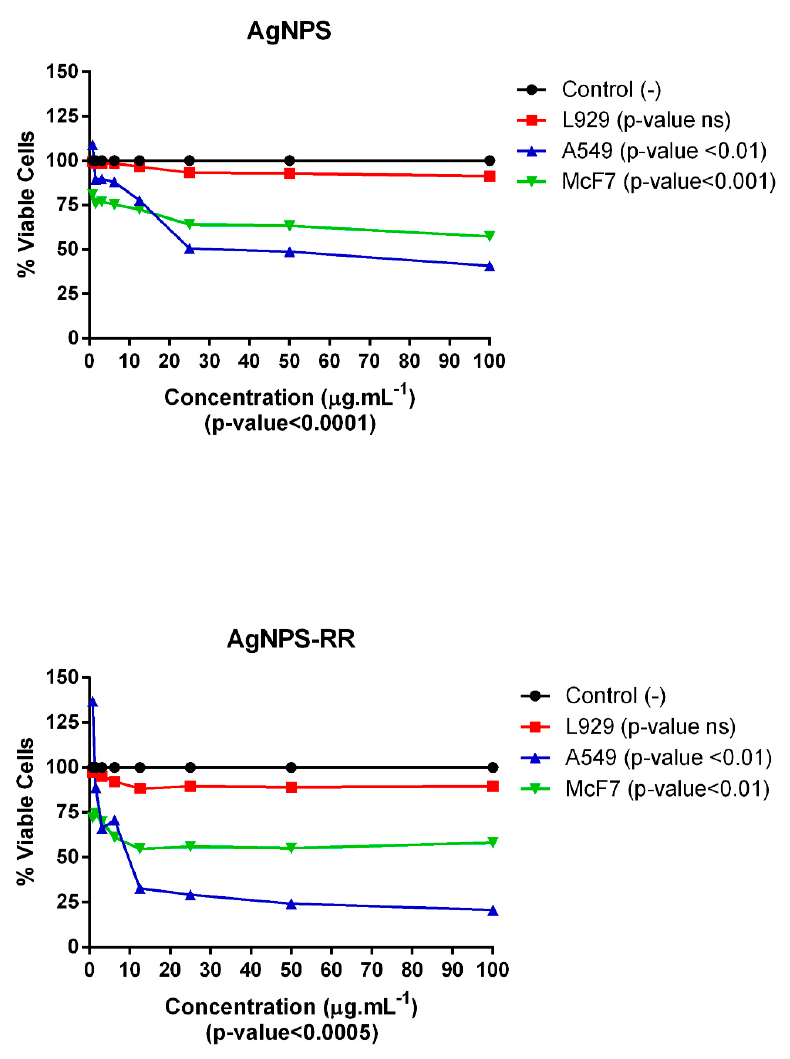
Figure 4. Cell viability with AgNPs and AgNPs-RR.